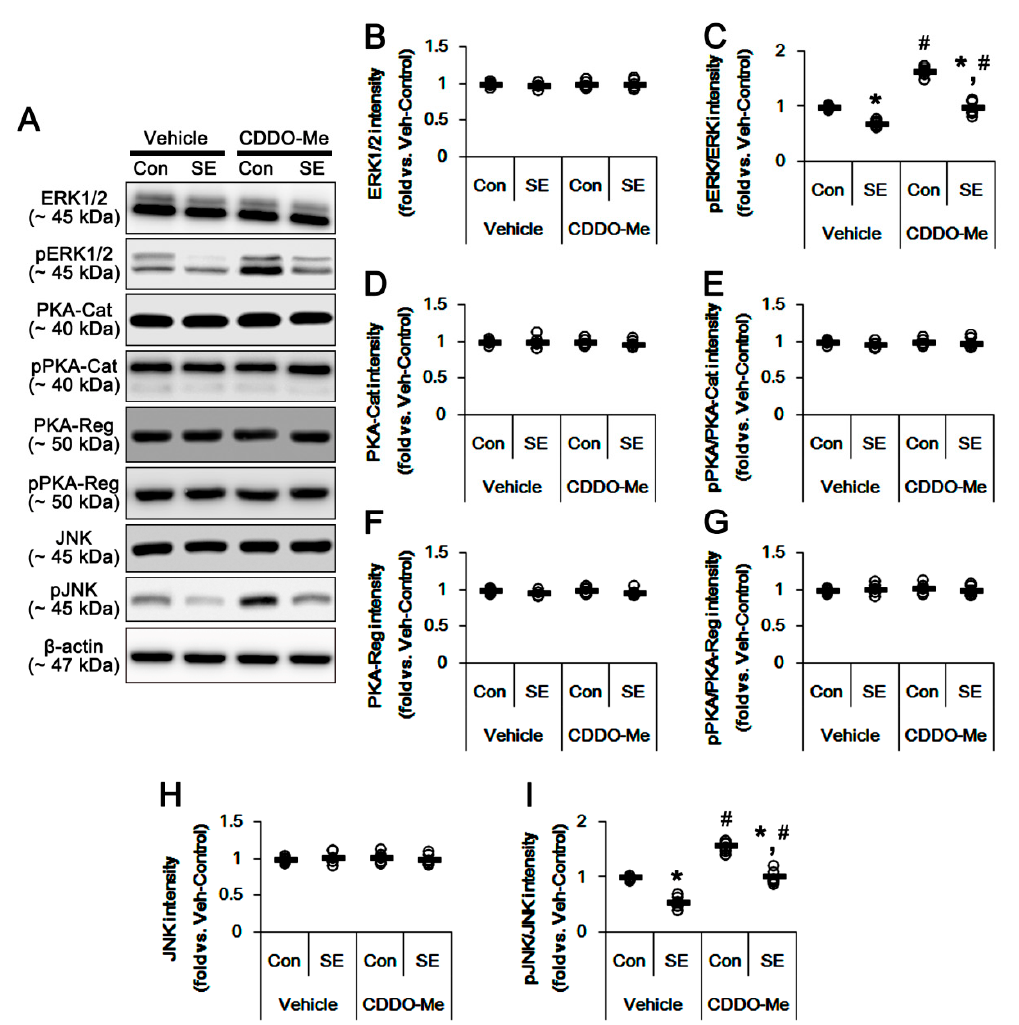
Figure 5. E ff ects of CDDO-Me on expressions and phosphorylations of extracellular-signal-regulated kinase 1 / 2 (ERK1 / 2), protein kinase A (PKA) and c-Jun N-terminal kinase (JNK). CDDO-Me increases ERK1 / 2 and JNK phosphorylation levels, but not PKA catalytic (PKA-Cat) and regulatory (PKA-Reg) subunits under physiological- and post-SE conditions. ( A ) Representative images for western blot of ERK1 / 2, phospho (p)-ERK1 / 2, PKA, pPKA, JNK and pJNK in the hippocampal tissues. ( B – G ) Quantifications of ERK1 / 2, pERK1 / 2, PKA, pPKA, JNK and pJNK levels. Open circles indicate each individual value. Horizontal bars indicate mean value. Error bars indicate SEM (* ,# p < 0.05 vs. control animals and vehicle, respectively; n = 7, respectively).